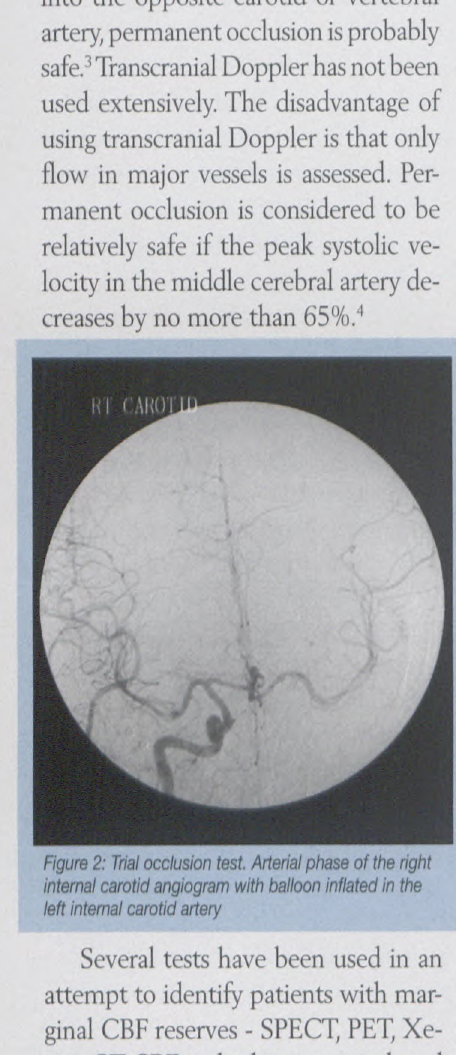
Figure 2: Trialocclusion test. Arterial phase of the right internal carotid angiogram with balloon inflated in the left internal carotid artery